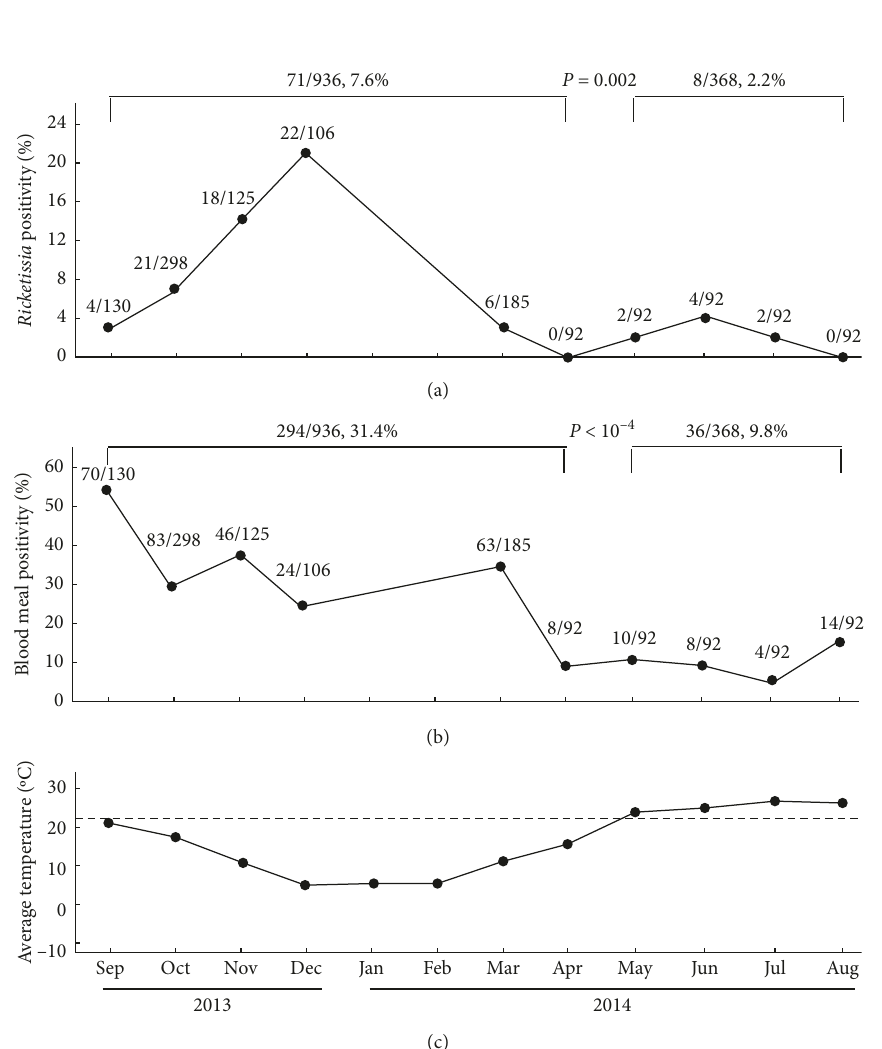
Figure 1: Significant higher R. felis and blood meal positivity in mosquitoes collected when the temperature was lower than 23 ° C than above 23 ° C. Mosquitoes collected in months with average temperatures below 23 ° C showed significant higher positivity of R. felis ((a); 71/936, 7.6% vs. 8/368, 2.2%; P � 0 . 002) and blood meal ((b); 294/936, 31.4% vs. 36/368, 9.8%; P < 10 − 4 ) than collected between May and August with above 23 ° C temperature (c).